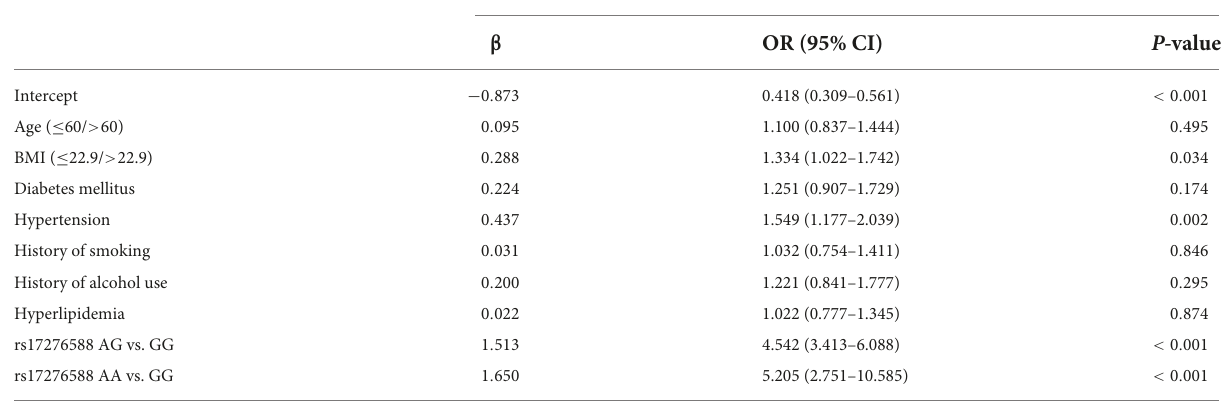
TABLE 4B Multivariate logistic regression analysis for the ischemic stroke (IS) risk factors among the male population. Intercept and variables